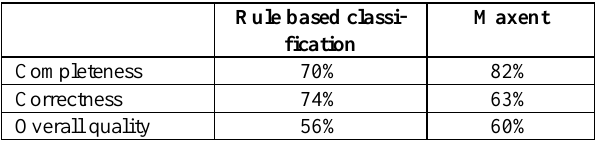
Table 4 Accuracy measures of two approaches on the same dataset. Training dataset differs between the two ap-